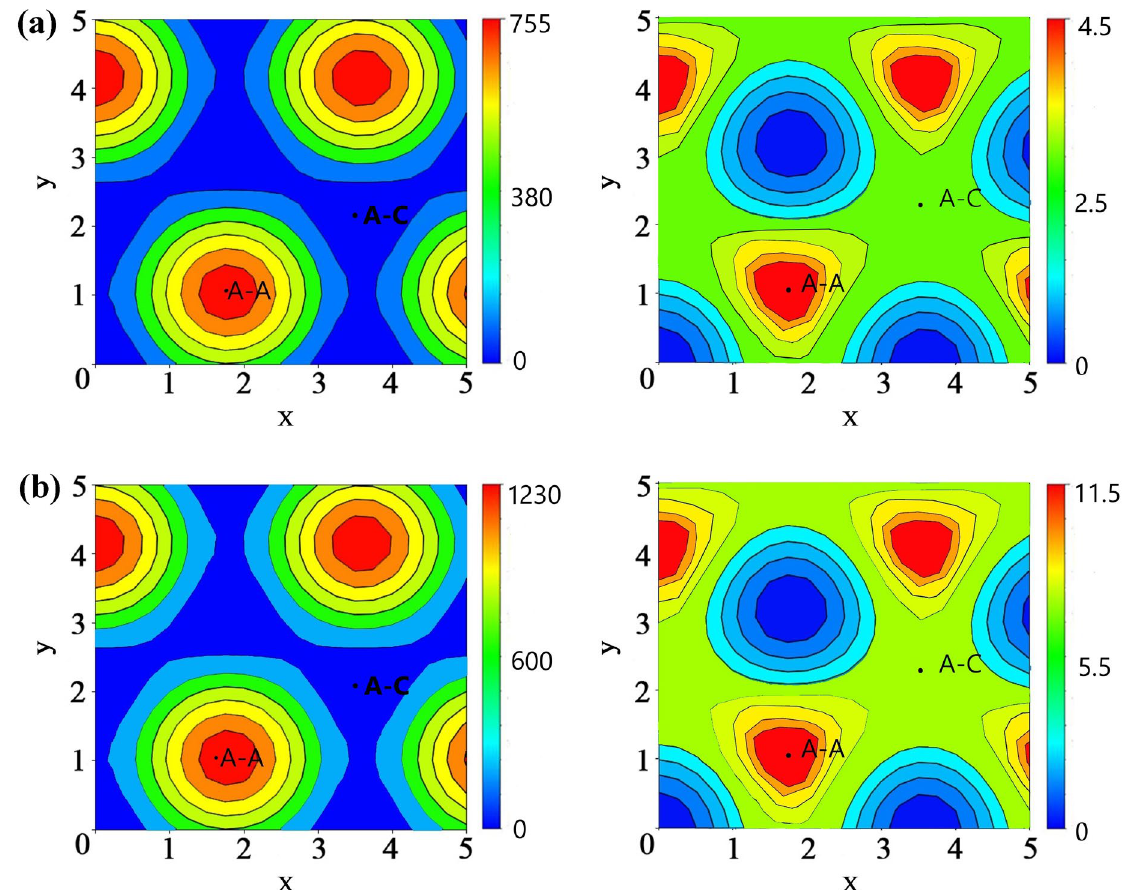
Figure 2. The potential energy surface (PES) (on-left) and polarization deviation surface (PDS) (on-right) for in-plane sliding of the InN bilayer when the interlayer distance is ( a ) 2.81 Å and ( b ) 2.51